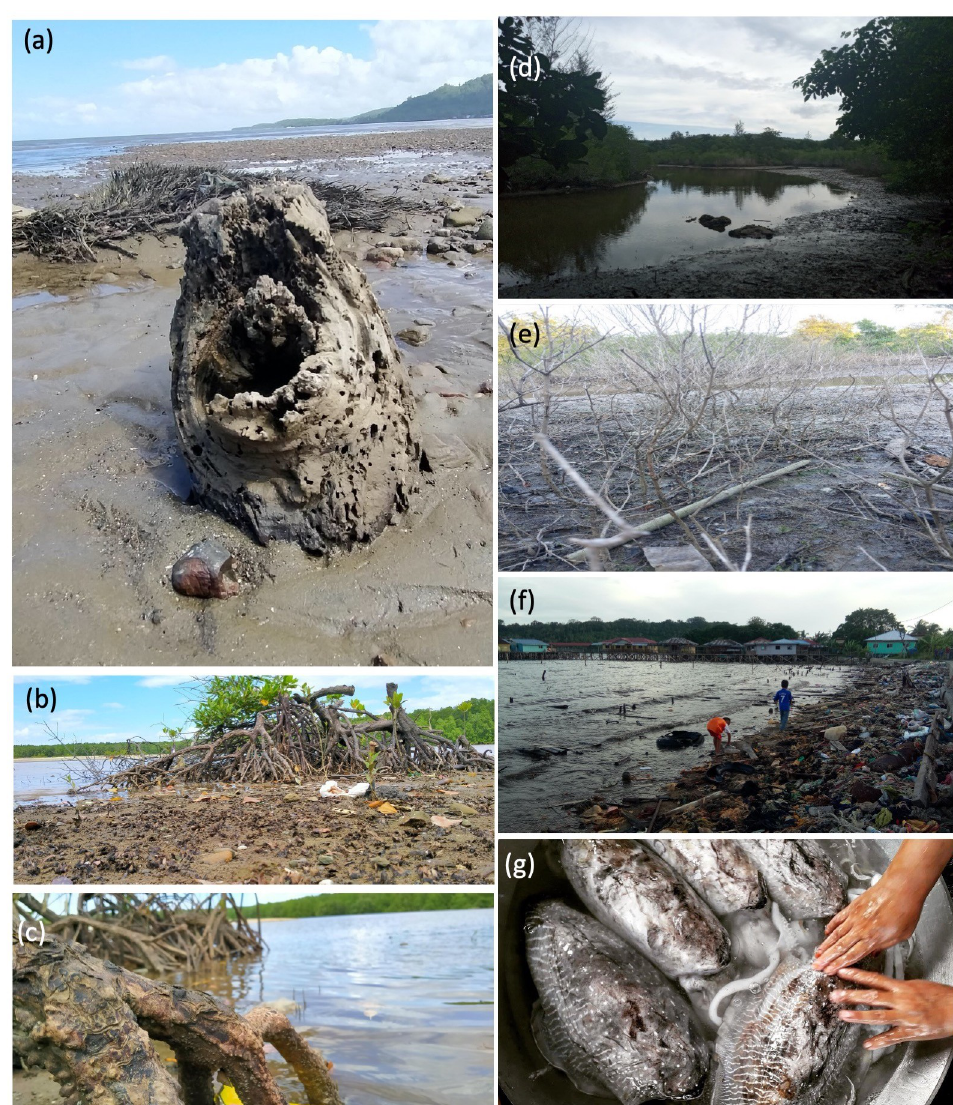
Fig 5. Photographs portraying environmental aspects of participants’ life associated with cultural, provisioning, regulating and supporting services. (a) Mangrove stumps were washed ashore during wet season and can be used for craft. (b) Unregulated cutting and pollution could cause the extinction of mangrove trees. (c) Unique looking roots of mangrove trees could strengthen the soil structure and prevent sea erosion at shore. (d) This river at a mangrove was experiencing erosion and becoming shallower, hence causing population decline of its inhabitants. (e) The river at this mangrove was drying up and have poor water flow, causing the trees unable to grow and hence died. (f) The poor waste disposal system had caused the accumulation of rubbish at this shore, causing discomfort to the villagers. (g) Cuttlefish is a local favourite seafood which used to be abundant in coral reefs surrounding the Banggi Island but is rarely caught nowadays due to uncontrolled fishing